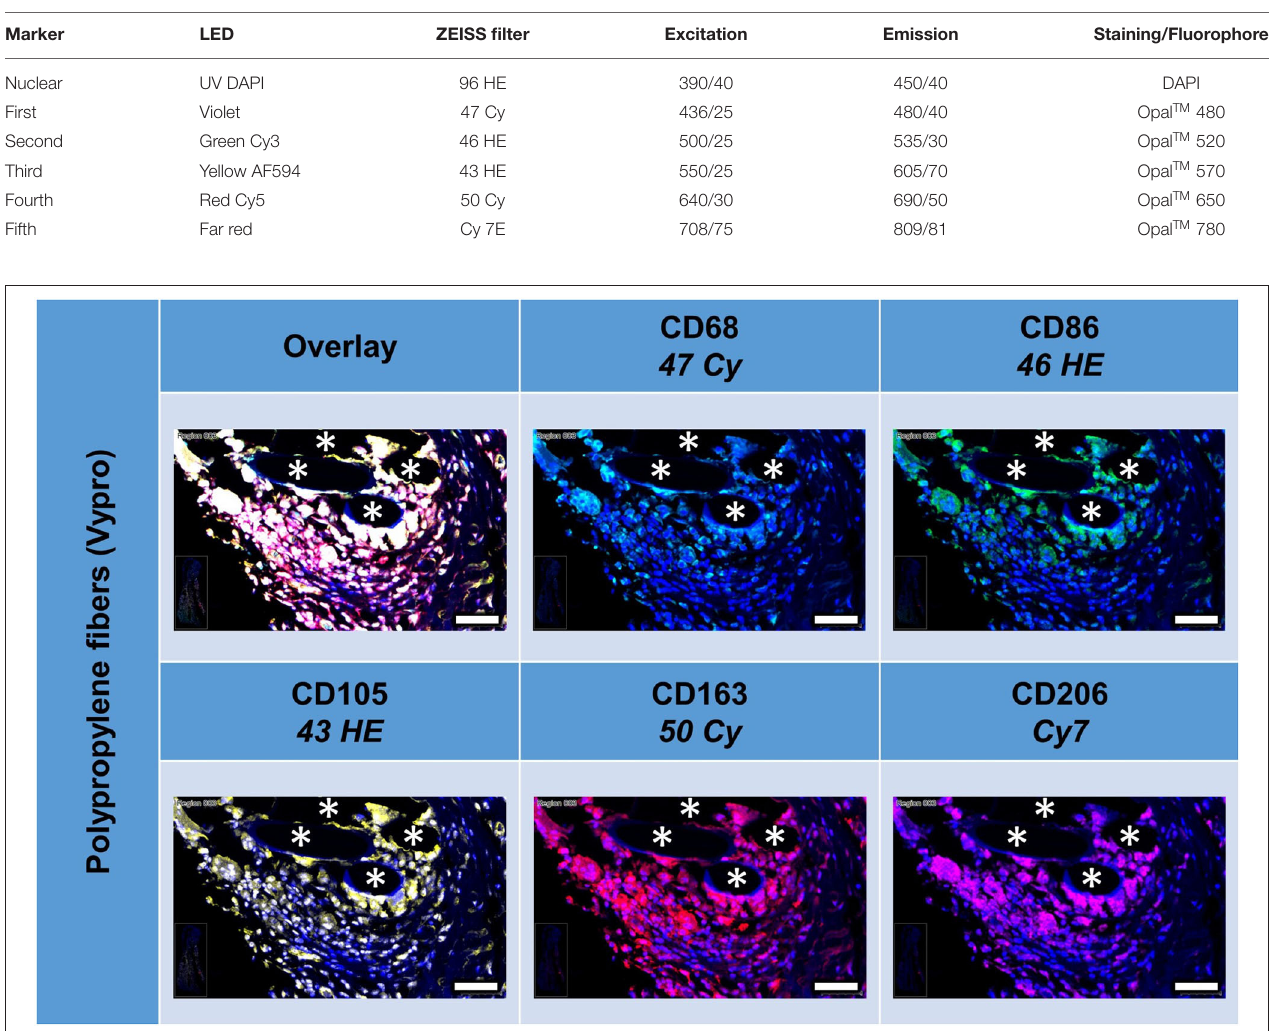
FIGURE 2 | Example of mesh-tissue section stained with macrophage panel. Labeling for nuclei with DAPI (blue), macrophages with CD68 (turquoise), M1 macrophages with CD86 (green), activated macrophages with CD105 (yellow), M2 macrophages with CD163 (red), and CD206 (magenta). Asterisks mark fiber locations, scale bars = 50 µ